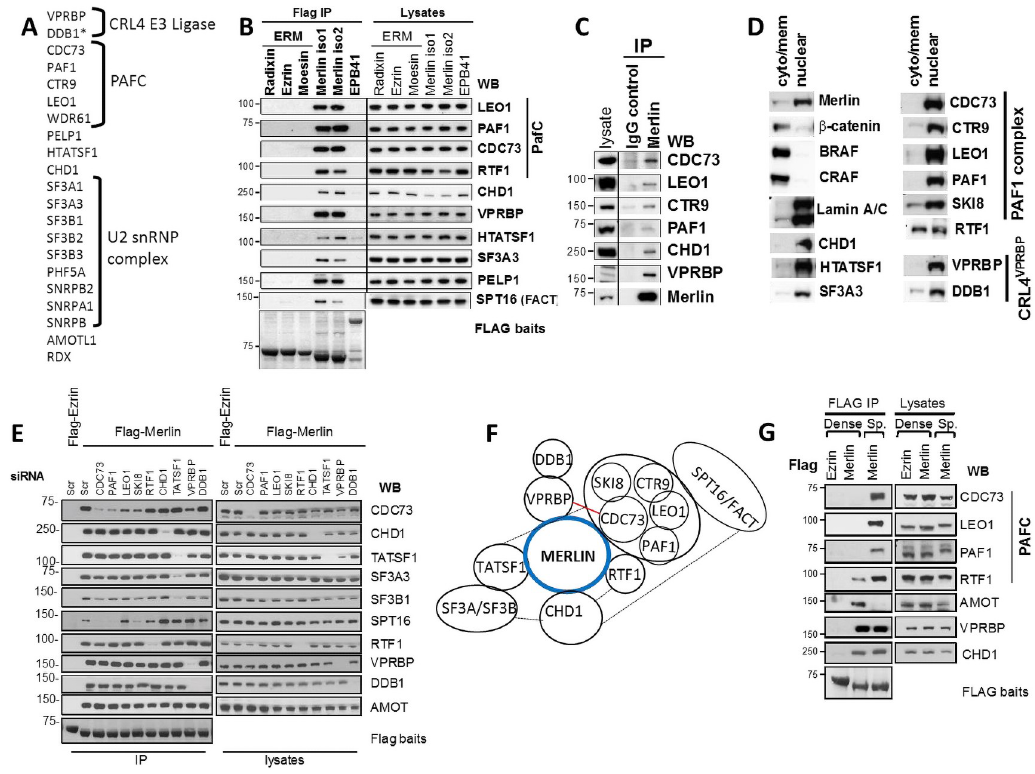
Fig 1. Merlin interacts with nuclear proteins that function in elongation and splicing. (A ) Proteins identified by mass spectrometry after Merlin affinity purification from HEK293T cells. (see also S1A Fig). ( B) Merlin isoforms 1 and 2 but not ERM proteins interact with proteins involved in transcription. Flag-tagged proteins were transfected in HEK293T cells and endogenous proteins detected on Flag IPs and lysates by western blot (wb). (C) Endogenous Merlin co-IPs with the PAFC, CHD1 and VPRBP. IPs of Merlin or control antibody from IOMM-Lee meningioma cells. (D) Merlin and its interactors reside in the nucleus. Western blot cytoplasmic/membrane and nuclear fractions from IOMM-Lee cells (see also S1B Fig). (E) Merlin independently binds to the PAFC, CHD1 and TAT-SF1. Flag-Ezrin or Merlin were purified from HEK293T cells transfected with the indicated siRNA oligos and interacting endogenous proteins detected by wb. (F) Schematic summarizing results from D. Dotted lines indicate interactions reported in the literature. Red line indicates interaction shown in Fig 4. Note that interactions between subunits of the PAFC are ‘arbitrary’. (G) Cell density inversely regulates Merlin’s interaction with the PAFC and AMOT proteins. Flag-Ezrin or Merlin were purified from either dense or sparse HMLE cells. See also S1 Fig. WB: Western blot, IP: Immunoprecipitation, Scr: scrambled control oligo, D: dense cells, S: sparse cells. See also S1